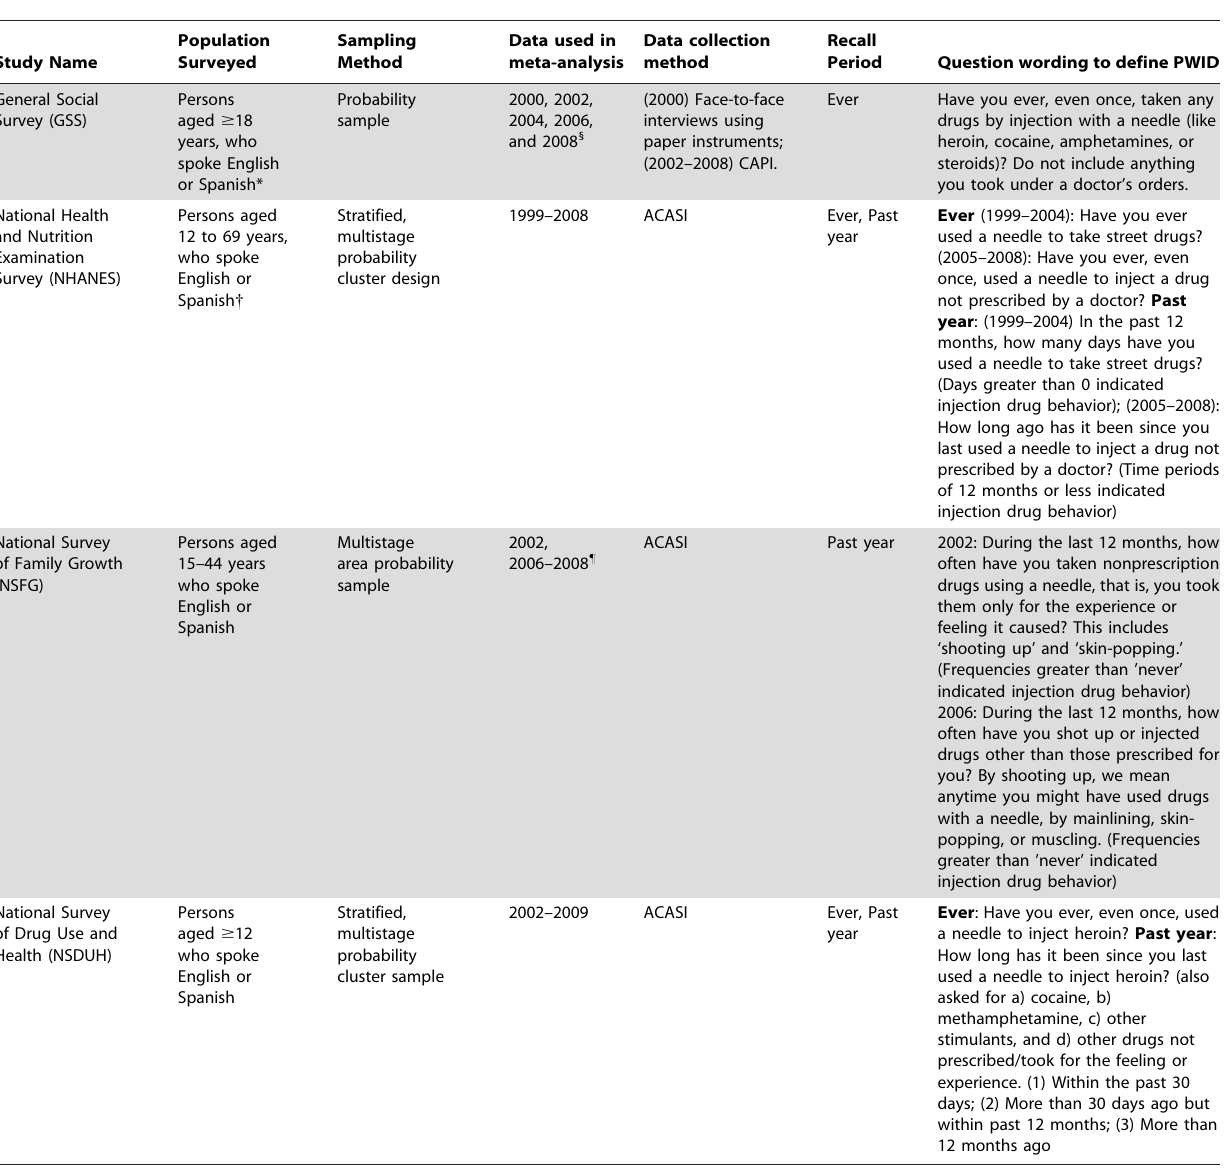
Table 1. Description of eligible studies for meta-analysis of the population proportion of PWID in the United